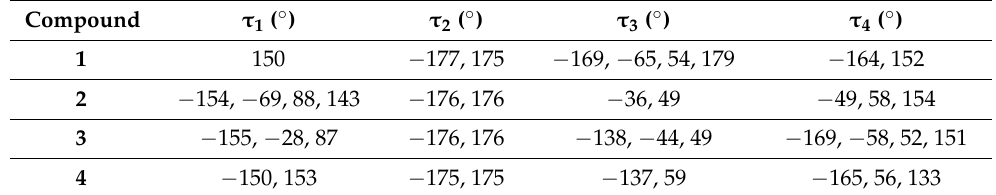
Table 4. Geometrical features, relative energies, and equilibrium percentages in water of the located conformations of compounds 1 – 4 .